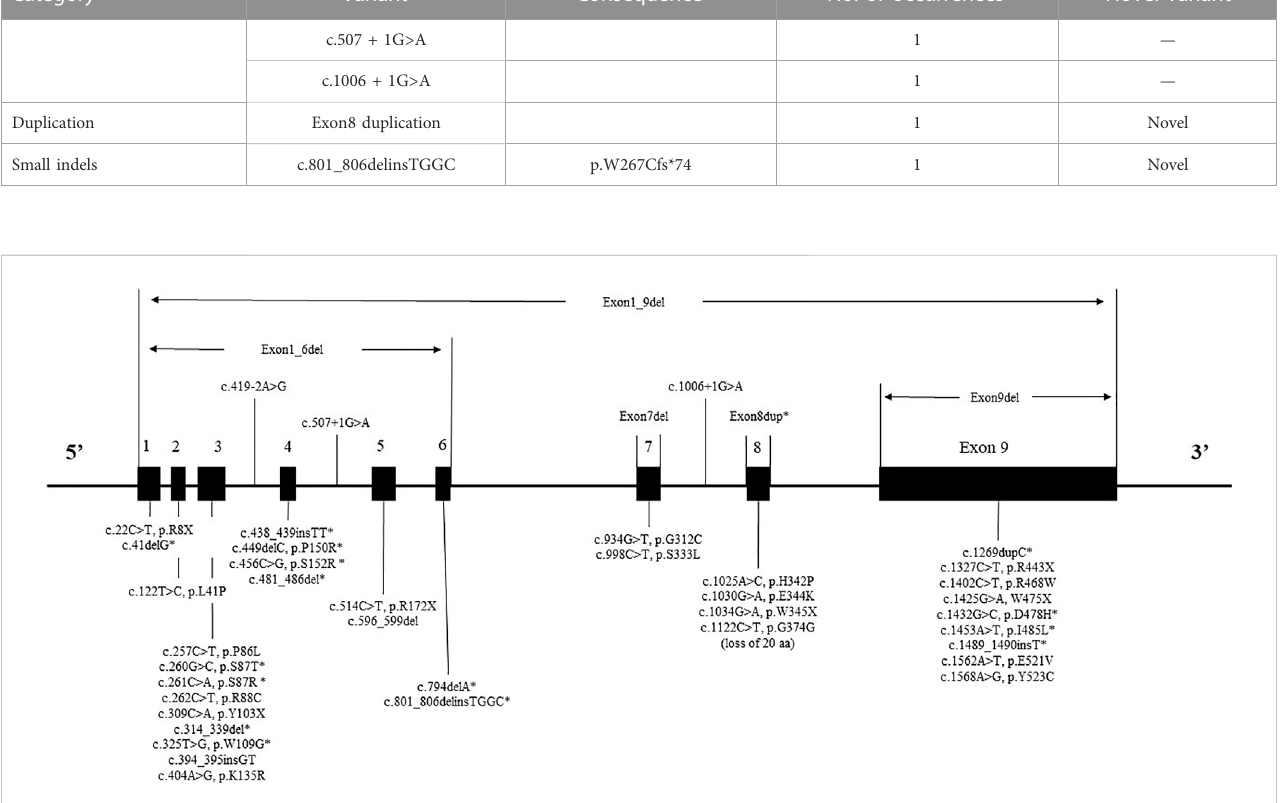
FIGURE 2 The mutant spectrum of IDS. * represents a novel